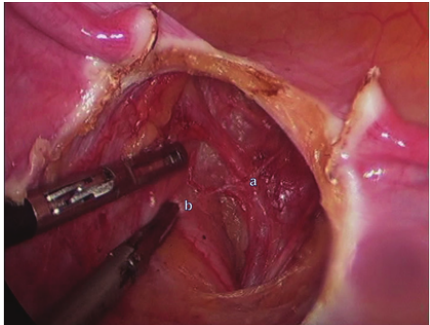
Figure 1: Identifying (a) uterine artery and (b) ureter by lateral dissection.